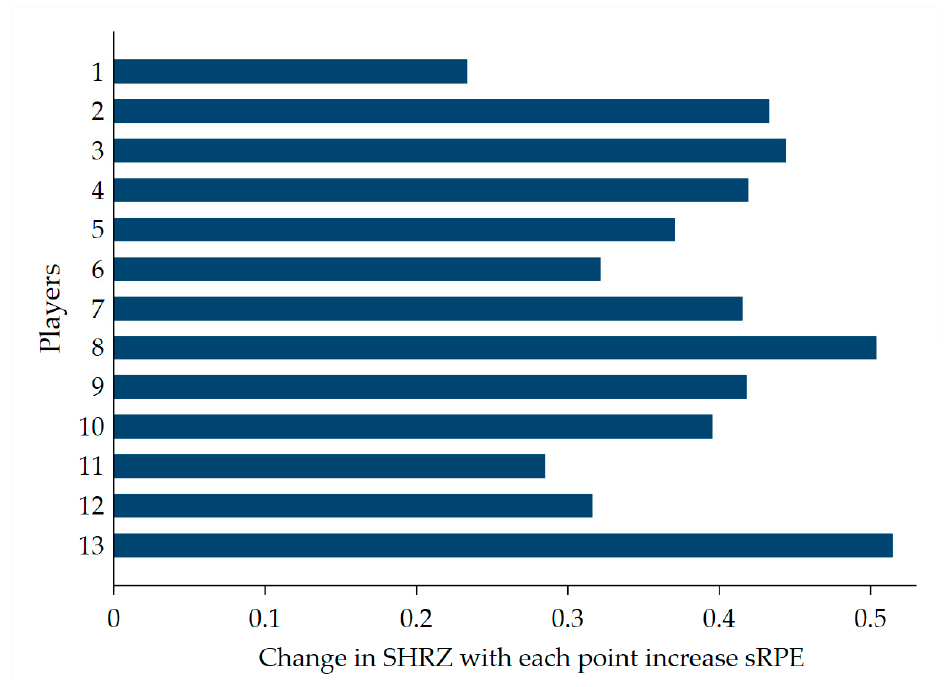
Figure 3. Interindividual variability of the relationship between the sRPE and SHRZ workloads. In some players (for example, 13 and 8), the SHRZ increased most steeply as the sRPE increased, whereas, in player 1, the increase was about the half of the abovementioned players.